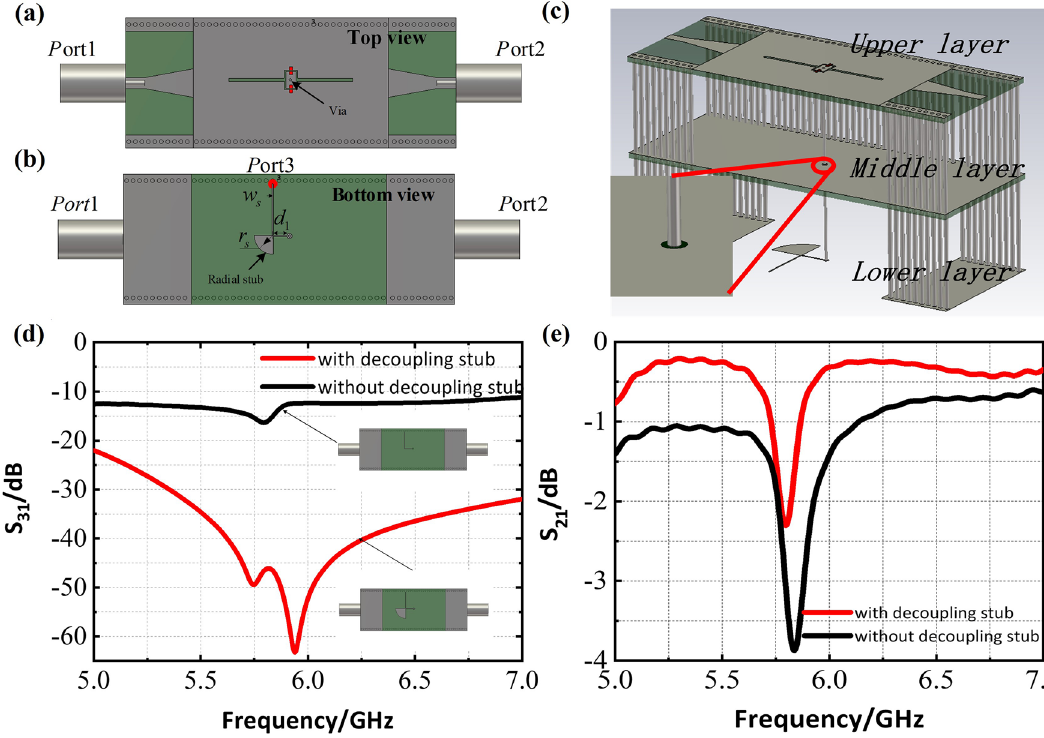
Figure 4. 2D sketch of slot element with the radial stub. ( a ) Front view. ( b ) Bottom view. Some optimized key parameters (length in mm) are: w s = 0.2 , d 1 = 4 , r s = 4.7 . ( c ) Exploded view of the SIW structure with the decoupling stub, the insert indicates that the metallic via is insulated from the ground. ( d ) Scattering parameters with Port-1 at end of the coaxial line and Port-3 connected to the end of DC bias line with and without radial decoupling stub. ( e ) Scattering parameters between Port-1 and Port-2 of the SIW structure with (red solid line) and without (black solid line) radial decoupling